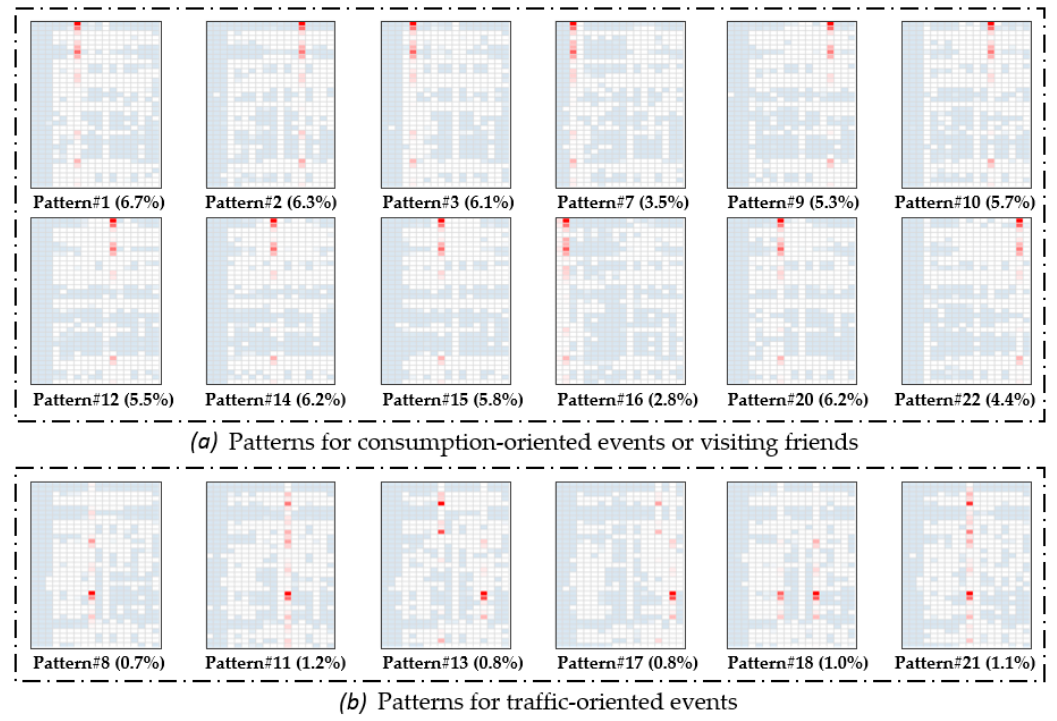
Figure 13. Remaining 18 mobility patterns on the holiday (U21).